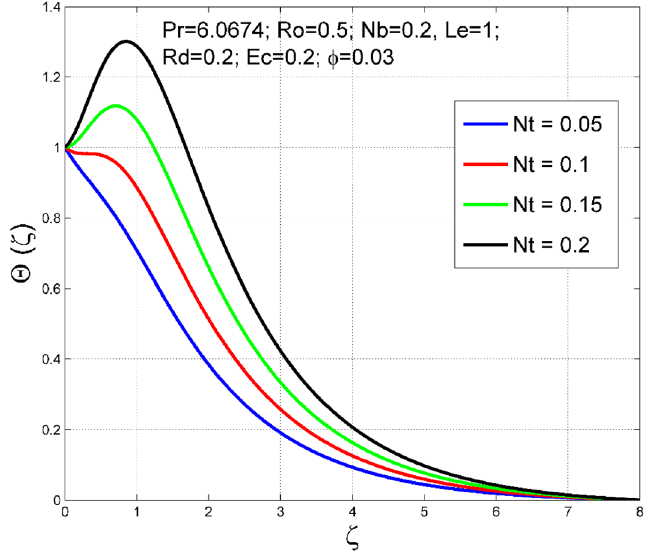
Figure 9. Effect of Nt on �(ζ) .